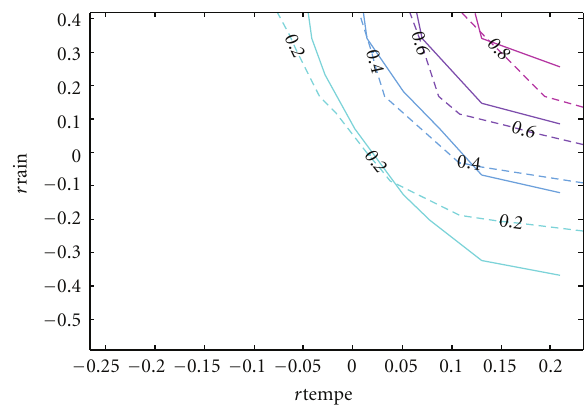
Figure 10: Real versus student fitted CDF. Note: The dashed lines are the real CDFs while the solid lines are the simulated CDFs. Table 4: Five families of copulas.